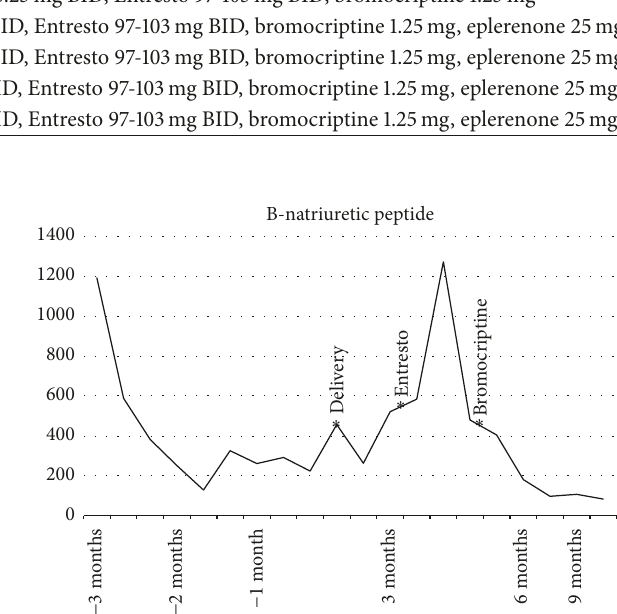
Figure 1: Progression of BNP levels during the peripartum